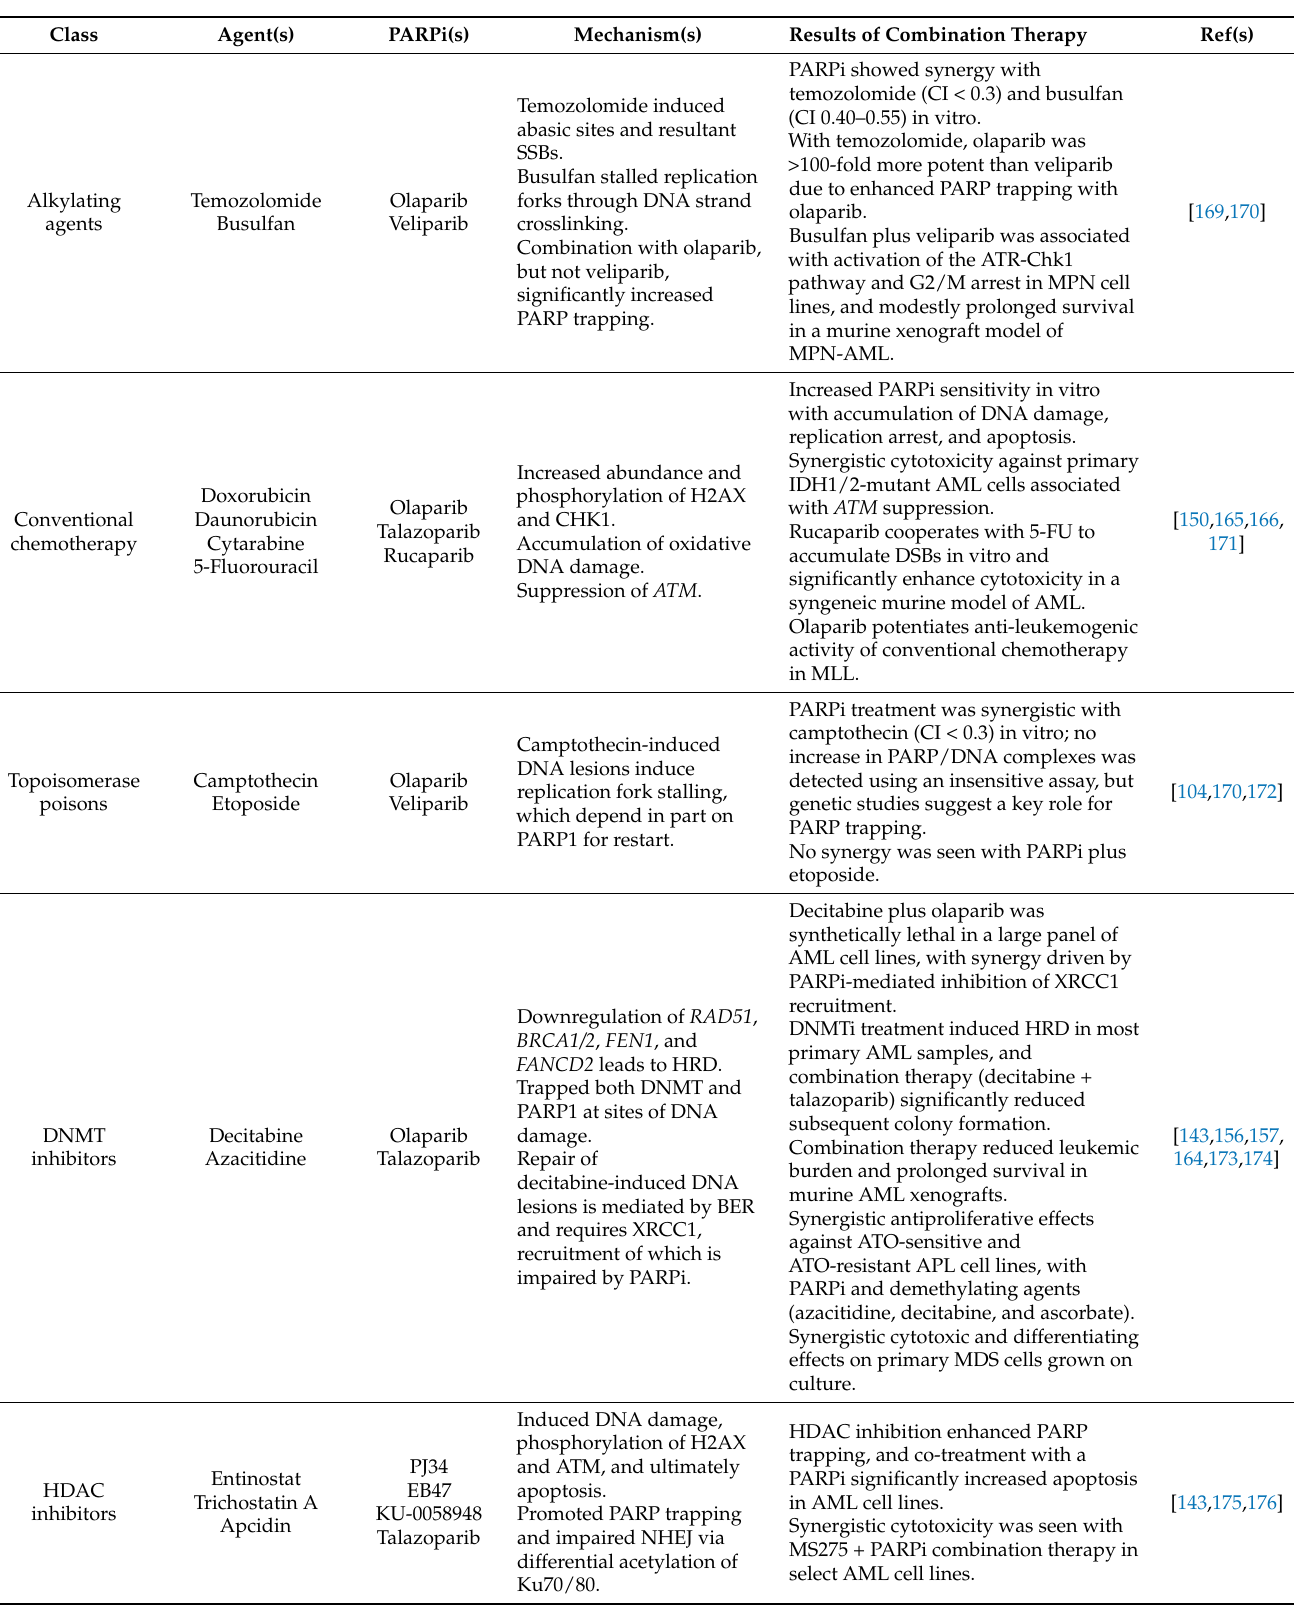
Table 2. Pre-Clinical Results of PARP Inhibitor Combination Therapy in Myeloid